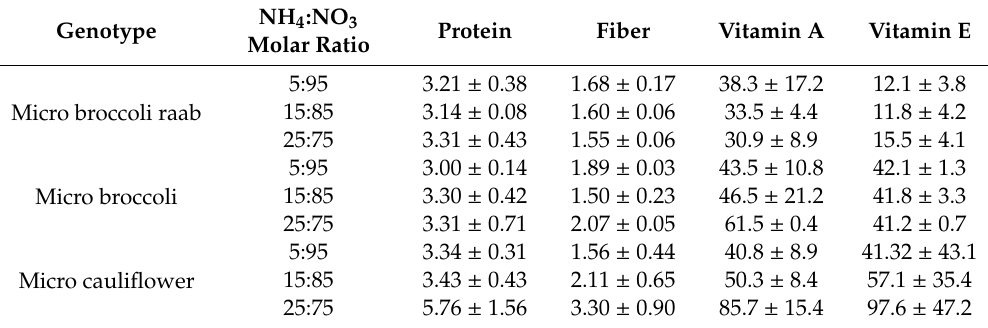
Table 4. Percent of nutritional contribution ( ± standard deviation) of protein, fiber, vitamin A (as β -carotene) and vitamin E (as α -tocopherol) per serving size of Brassica microgreens based on the Dietary Reference Values (DRV).